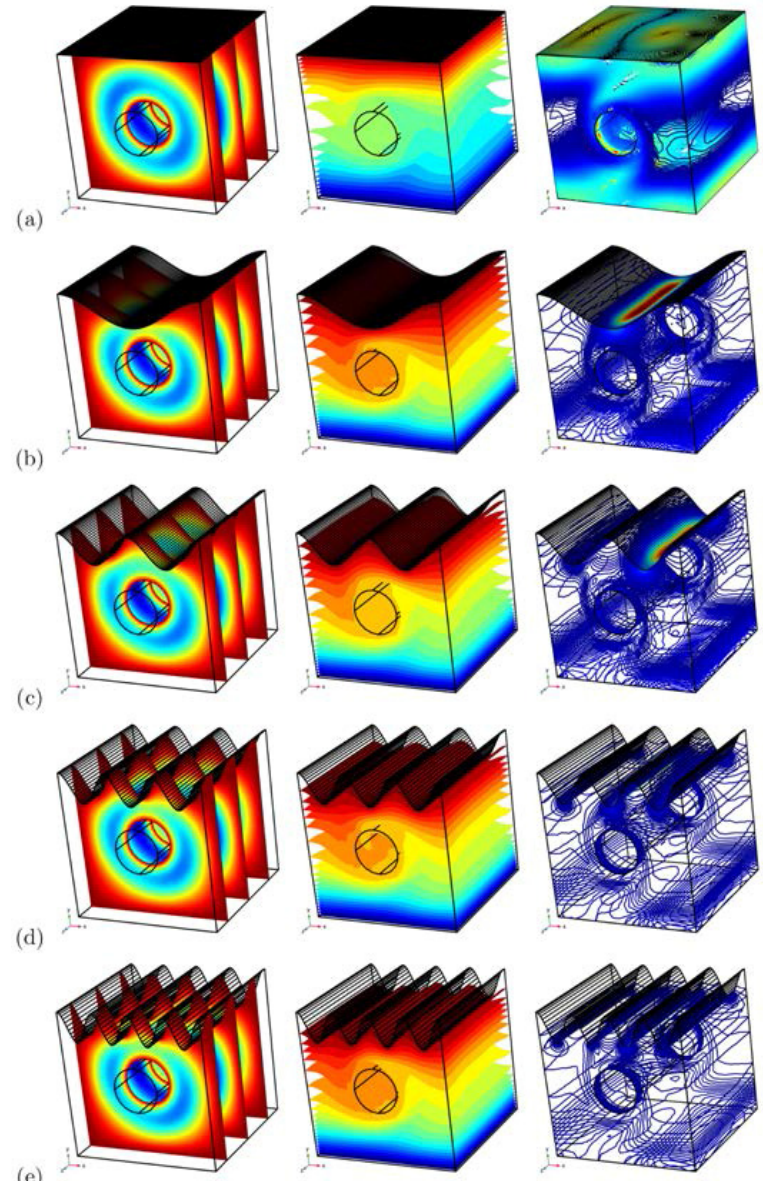
Figure 6. ( left ) 3D streamlines, ( centre ) isotherms and ( right ) isentropic lines: ( a ) N = 0, ( b ) N = 1, ( c ) N = 2, ( d ) N = 3 and ( e ) N = 4 for Ri = 10 and φ =